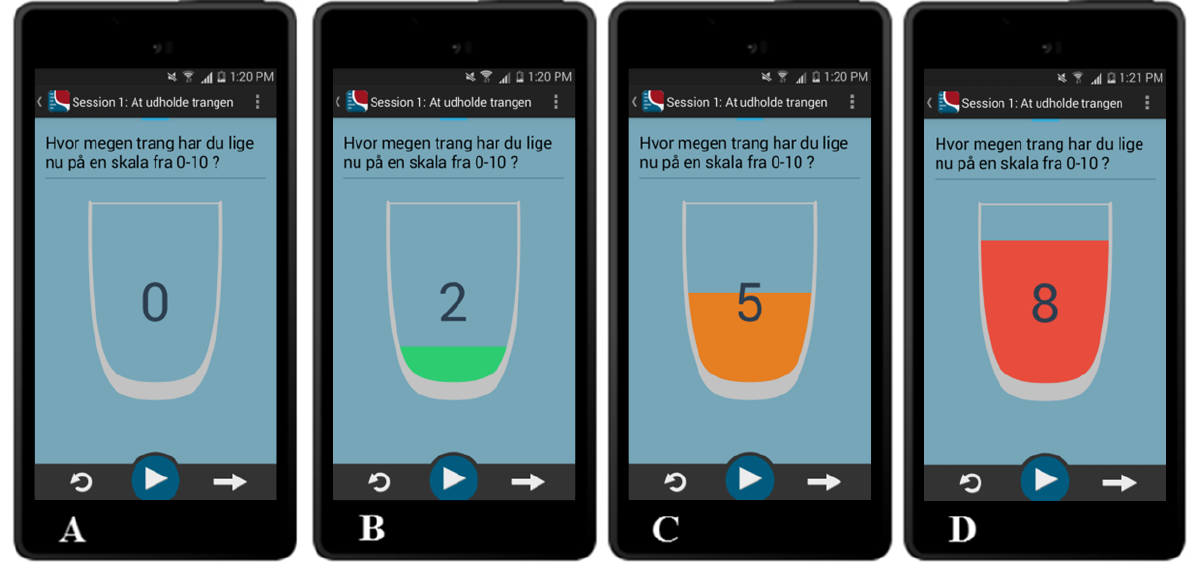
Figure 5. Real-time measures of cue-induced cravings.